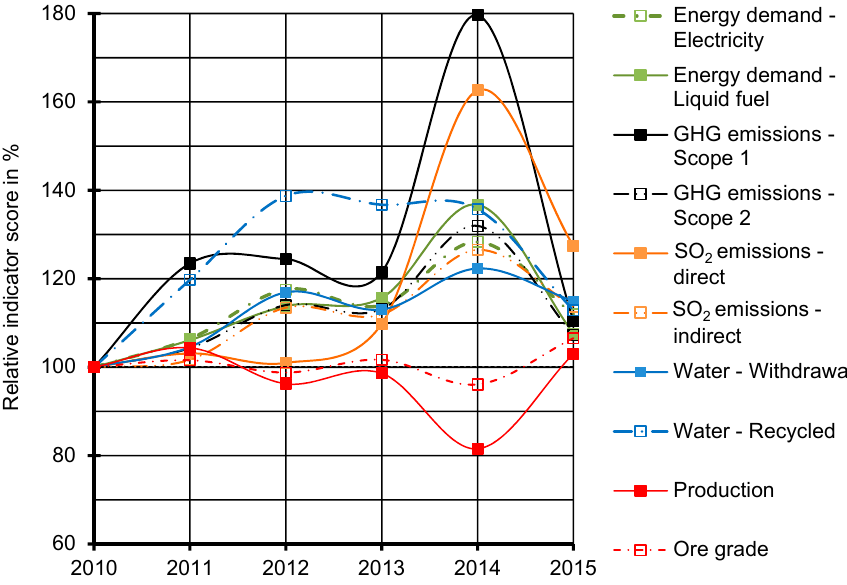
Figure 12. Change in indicator scores in percent from 2010 to 2015 (2010 = 100%).